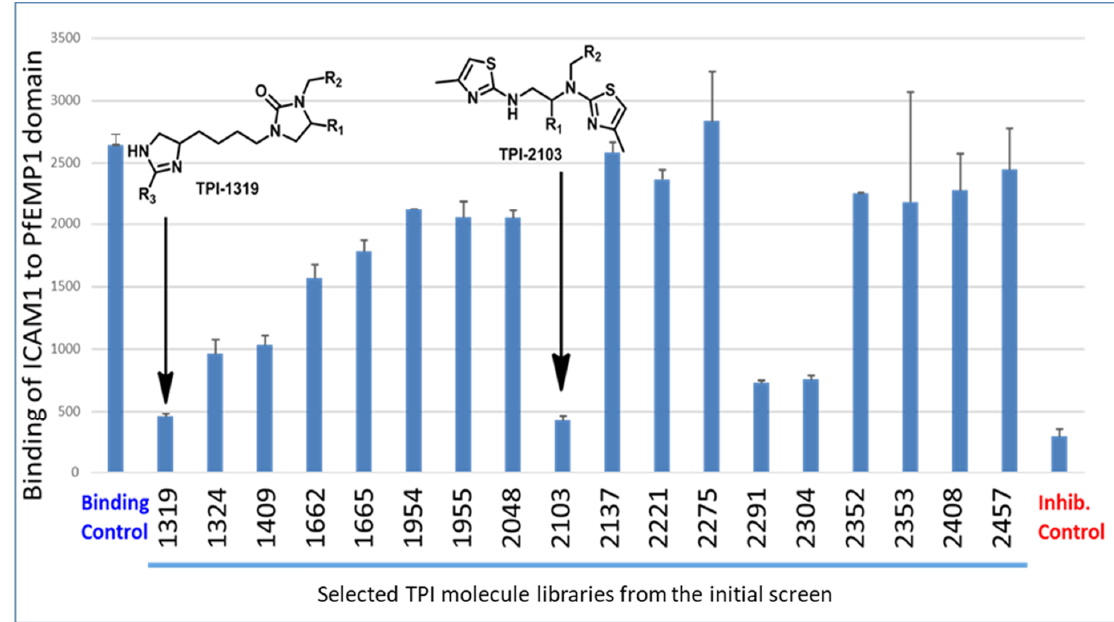
Figure 1. Confirmation of hits from initial screen using selected inhibiting and non-inhibiting libraries. Graph shows binding of ICAM-1receptor in solution to a bead-bound PfEMP1 PF11_0521 DBL2β3 domain. Binding control—no compound library added, binding buffer contains the same amount of DMF as samples with compound libraries. Inhibition control—ICAM-1 receptor pre-incubated with mAb My-13 [31]. Dilution of each library is 1:10. AFU, Arbitrary fluorescence units. Error bars are SD from duplicates. All inhibitions are highly significant (one-way ANOVA, Dunnett’s multiple comparison test, p < 0.0001 for TPI 1319, 1324, 1409, 2103, 2291, 2304, and inhibition control; p < 0.001 for TPI 1662, p < 0.01 for TPI 1665).